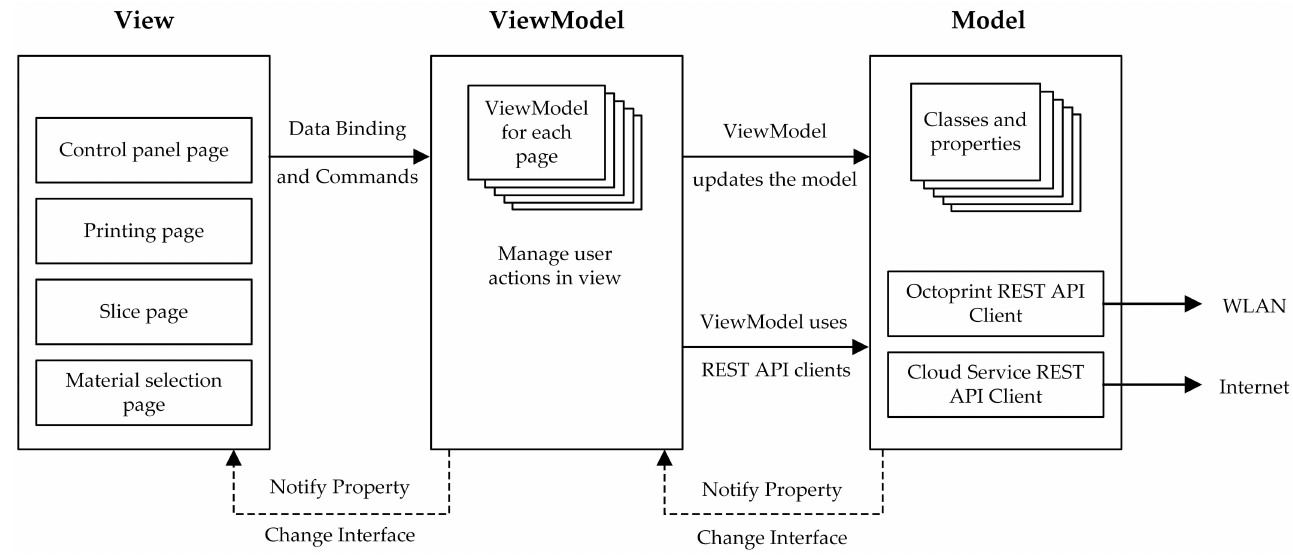
Figure 4. MVVM approach on end-user